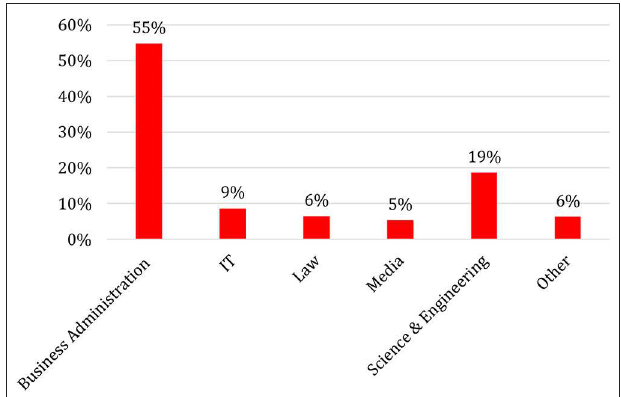
FIGURE 1 | Educational background of FinTech founders (in %), N = 422.